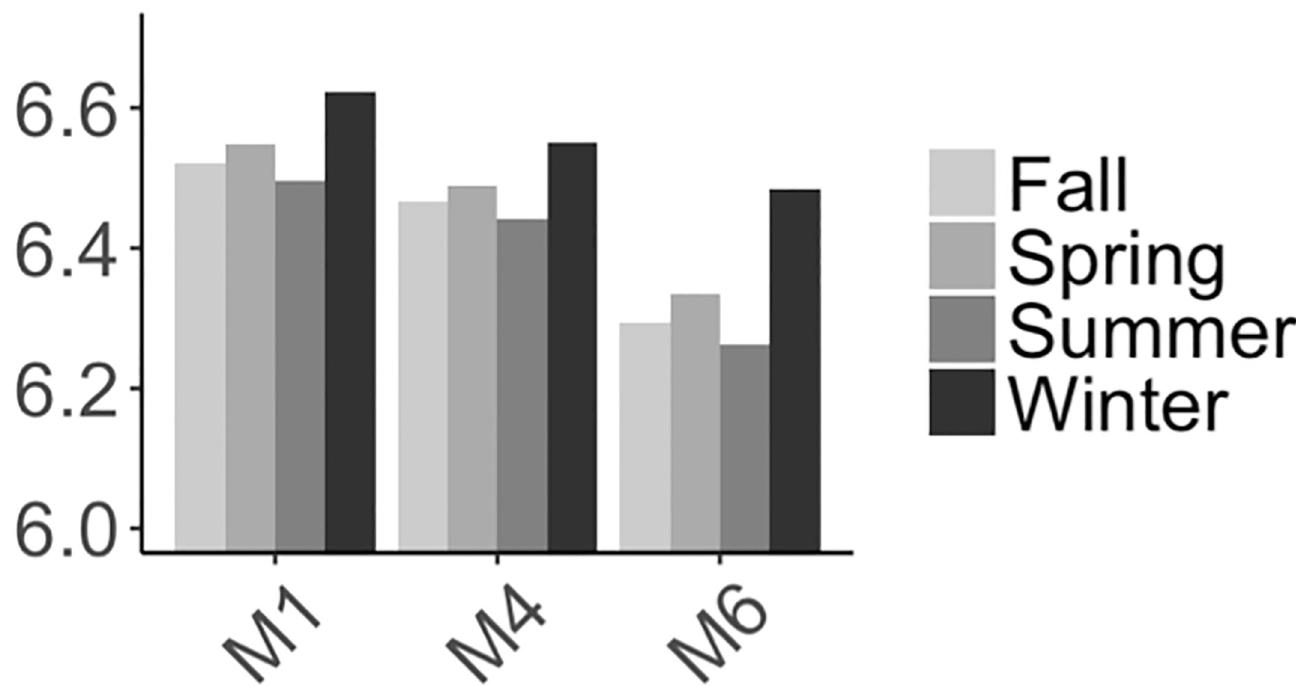
Fig 18. Estimated coefficients of seasonal trend of Manhattan.